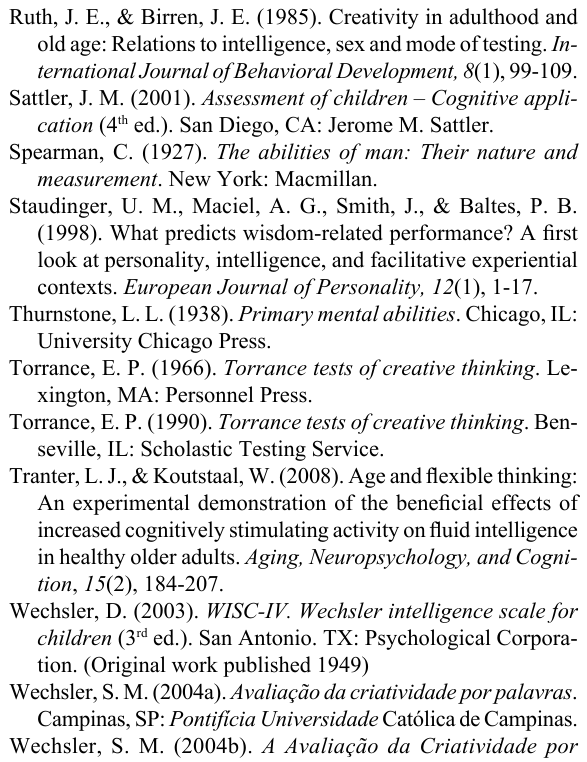
Figuras . Campinas, SP: Pontifícia Universidade Católica de